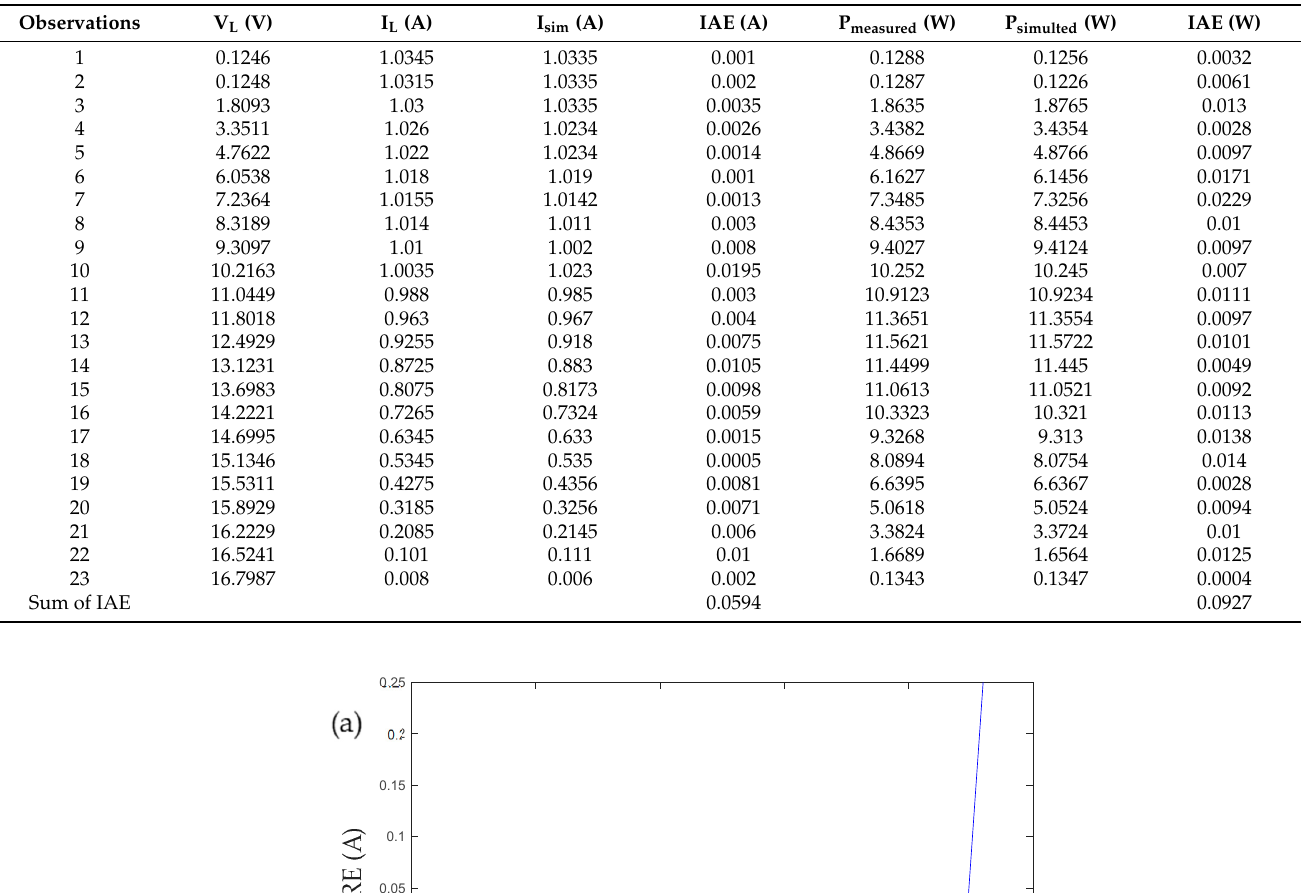
Table 3. The calculated current and absolute error results of TSA (Tunicate swarm algorithm) for solar PV (Photovoltaic) module.